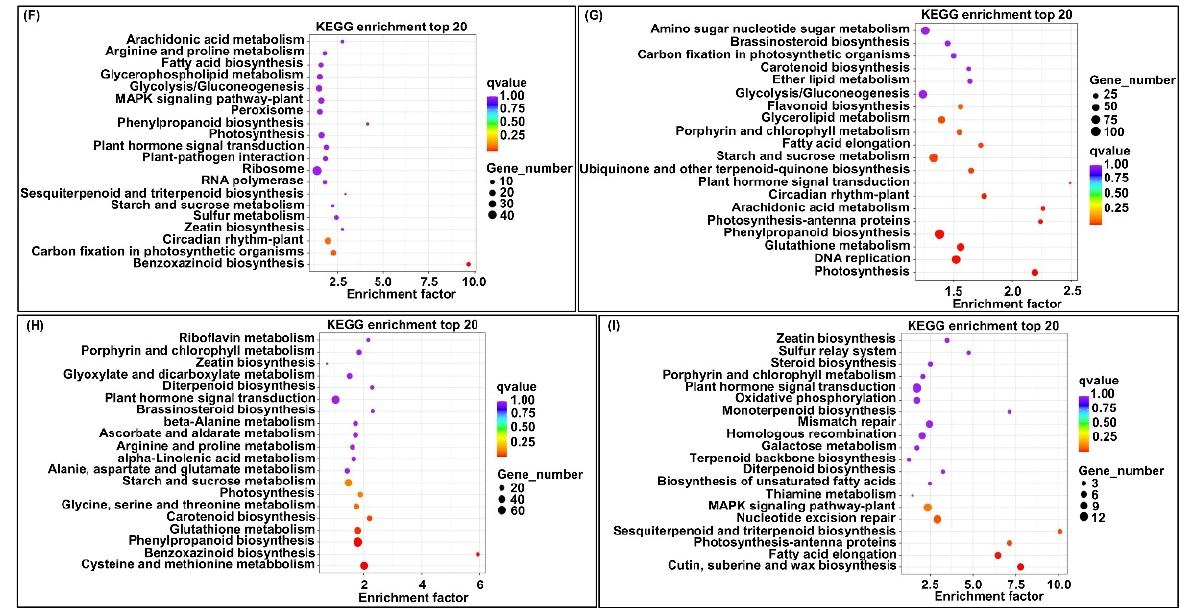
Figure 5. Transcriptional levels of maize mesocotyls at two sowing environments. ( A ) Based on the log2 fold ‐ change value of the comparisons, a hierarchical clustering of genes was performed with W64A and K12 for two conditions to obtain four clusters. ( B ) The representative expression patterns of four clusters were screened. ( C ) All differentially expressed genes (DEGs) were analyzed in VS1 [W64A (20 cm)_VS_K12 (20 cm)], VS2 [W64A (3 cm)_VS_K12 (3 cm)], VS3 [W64A (20 cm)_VS_W64A (3 cm)], and VS4 [K12 (20 cm)_VS_K12 (3 cm)] comparisons; the bar charts indicated DEGs in a single comparison (the x ‐ axis represents the number of genes); column charts indicated DEGs in single or multiple comparisons (in the x ‐ axis, black dots represented a single comparison; black lines connected by dots represented multiple comparisons; and the y ‐ axis represented the number of cor ‐ responding genes). ( D ) DEGs identified among four comparisons and 24 core conserved DEGs ob ‐ tained in all comparisons. ( E ) The expression patterns of 24 core conserved DEGs in four compari ‐ sons; the red ‐ box or green ‐ box representing the corresponding DEG was up ‐ regulated or down ‐ regulated, and the value in the box was the log2 fold ‐ change of the corresponding DEG. ( F – I ) KEGG pathways enriched in DEGs in VS1, VS2, VS3, and VS4 comparisons, respectively.